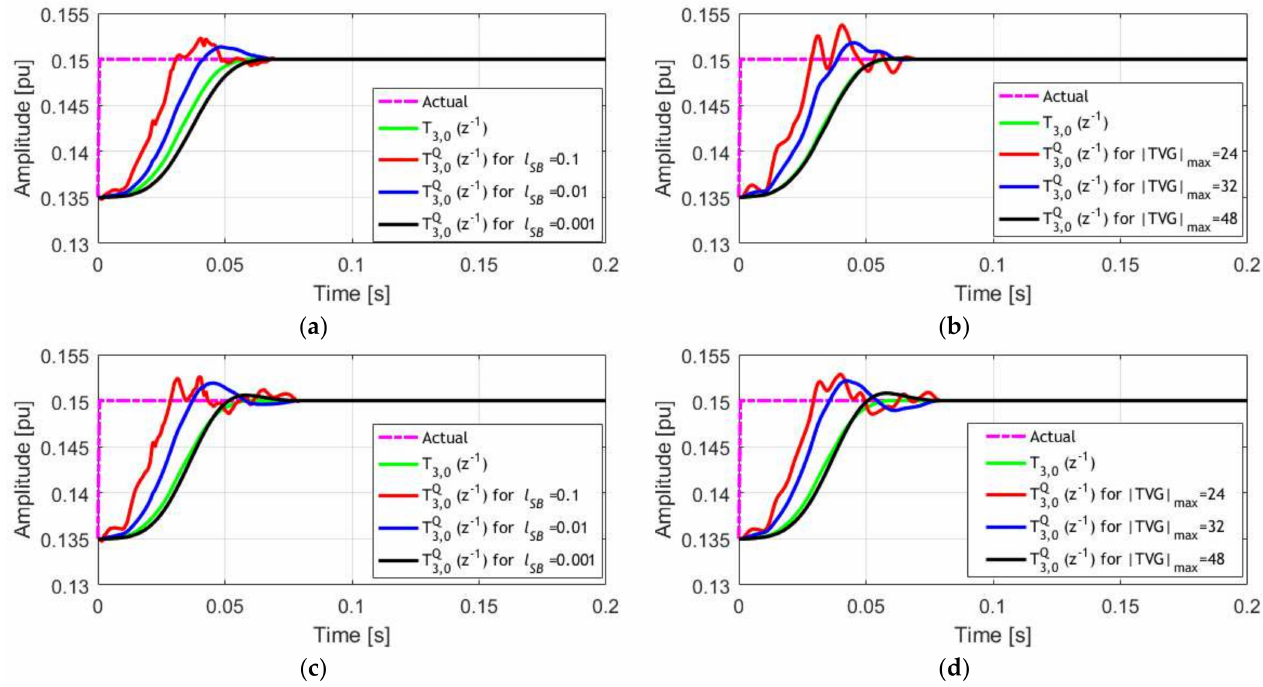
Figure 7. Simulation results obtained for the amplitude step signal, for K = 2, with f 1 = 50 Hz and f S = 1600 Hz, for: ( a ) Task 1 for N Q = 16, ( b ) Task 2 for N Q = 16, ( c ) Task 1 for N Q = 32, ( d ) Task 2 for N Q =